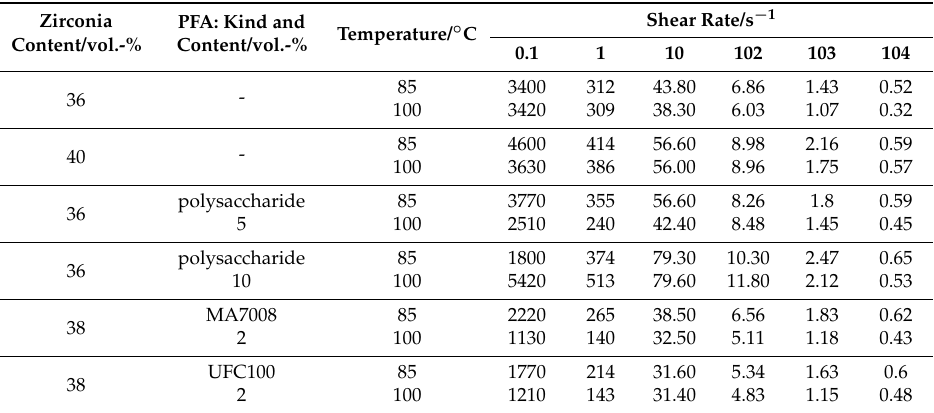
Figure 13. Rheological behavior of zirconia suspensions with and without PFA at 100 ◦ C. Table 2. Dynamic viscosity of the suspensions at different shear